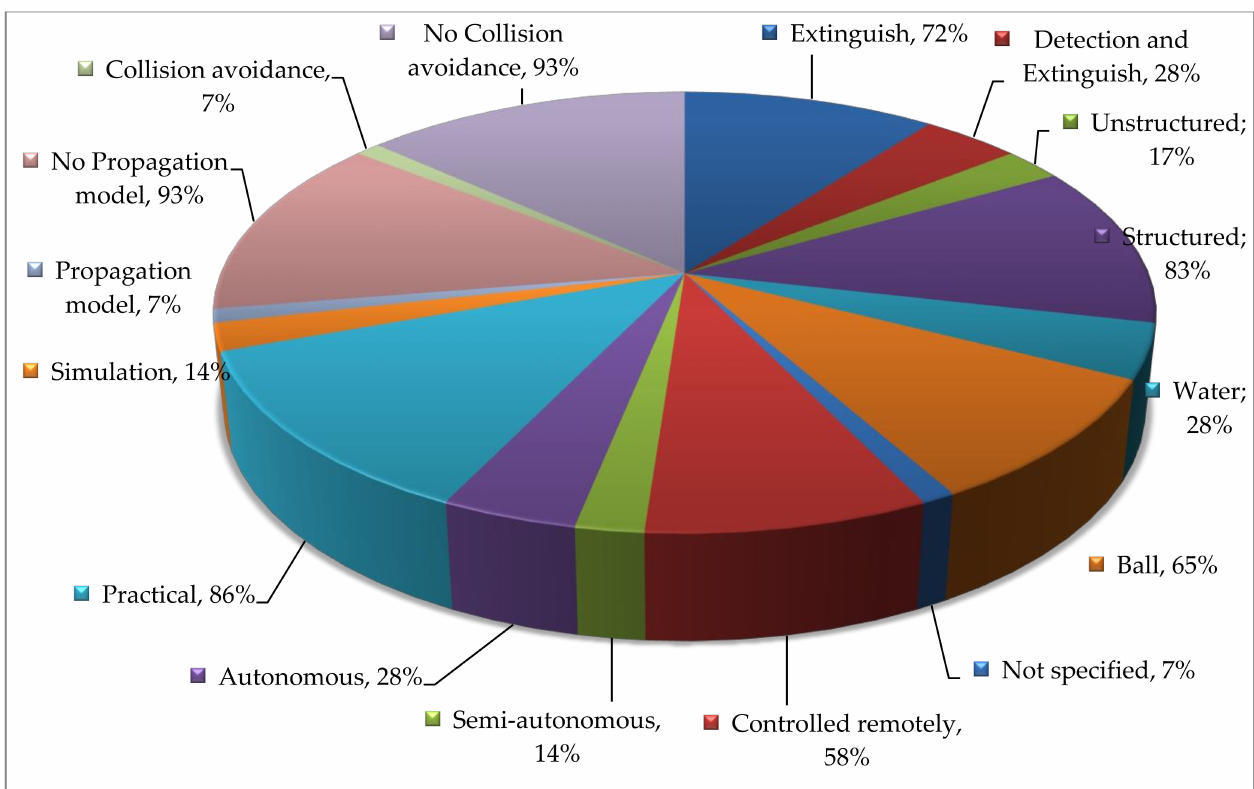
Figure 8. The percentages of number of papers per characteristic of fire-extinguishing systems using a single